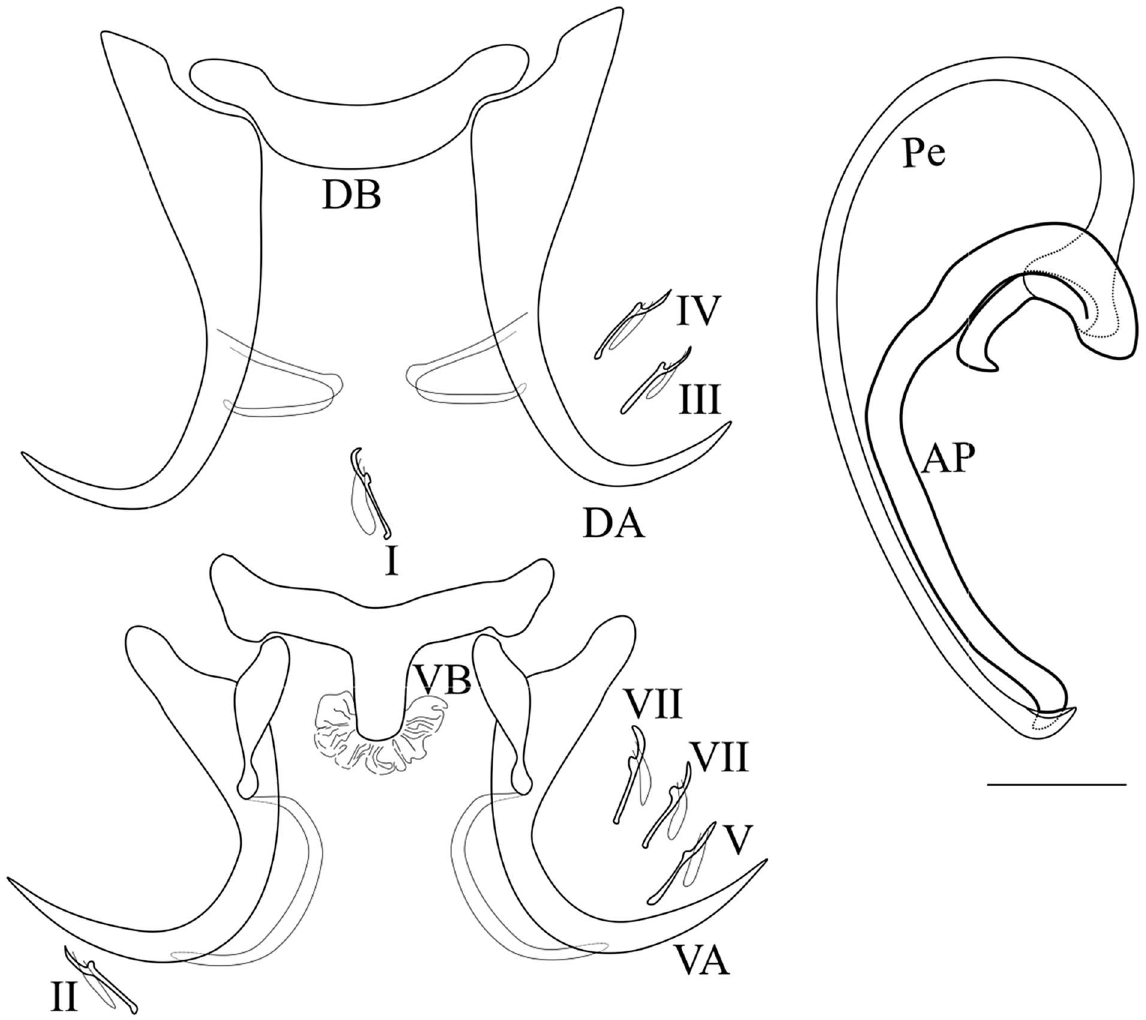
Figure 3. Sclerotized parts of Synodontella longipenis n. sp. Scale bar = 20 l m. AP, accessory piece; DA, dorsal anchor; DB, dorsal bar; VA, ventral anchor; VB, ventral bar; Pe, penis; I-VII,